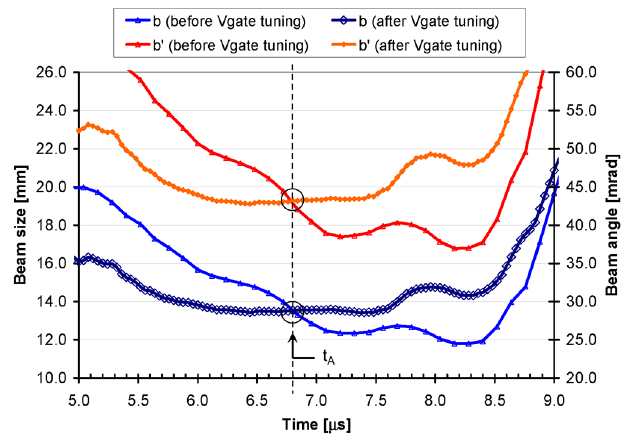
FIG. 16. (Color) Vertical envelope parameters [ b (dark blue and light blue curves) and b 0 (red and orange curves)] at QD1 diagnostics station as a function of time before and after the extractor voltage